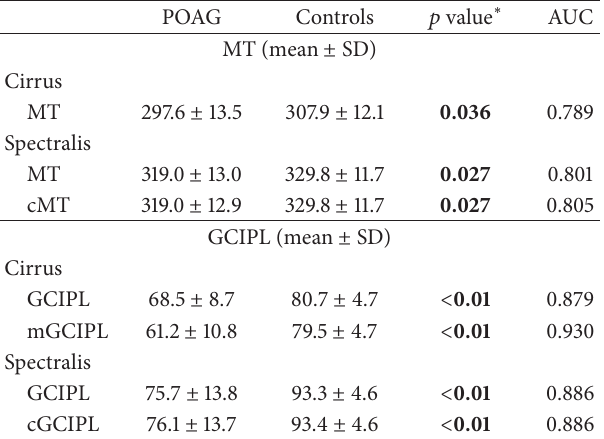
Table 3: Total macula and ganglion cell layer mean thickness, in micrometers ( 𝜇 m), among groups and p values in the central 10 ∘